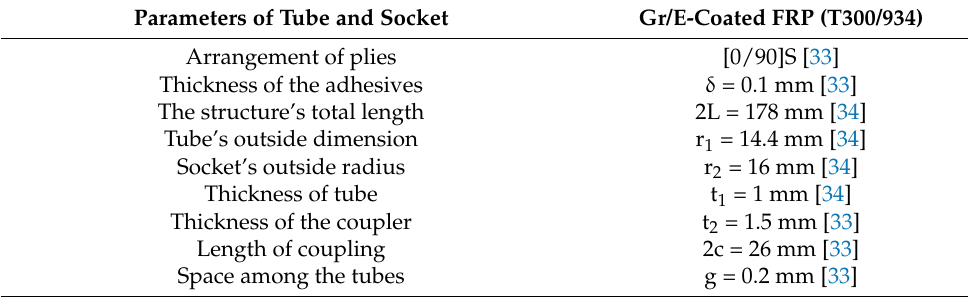
Table 1. Geometrical characteristics of bonded cylindrical socket.